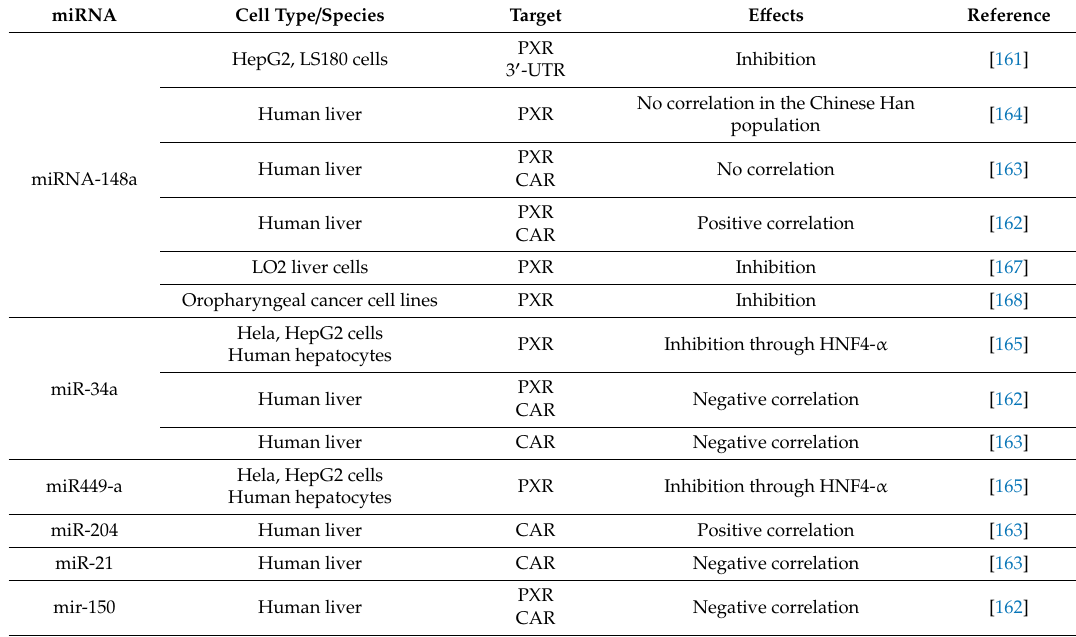
Table 2. miRNAs that regulate CAR and PXR